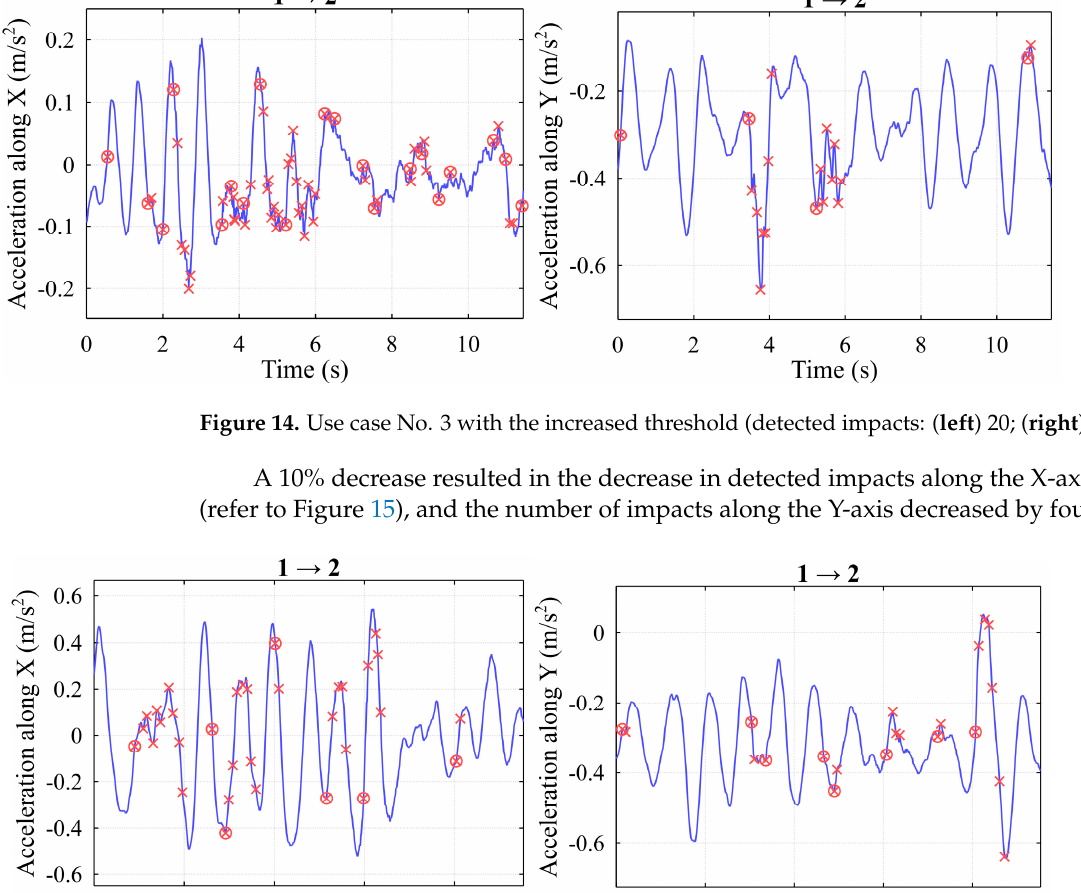
Figure 13. Use case No. 2 with the increased threshold (detected impacts: ( left ) 7; ( right ) 13).